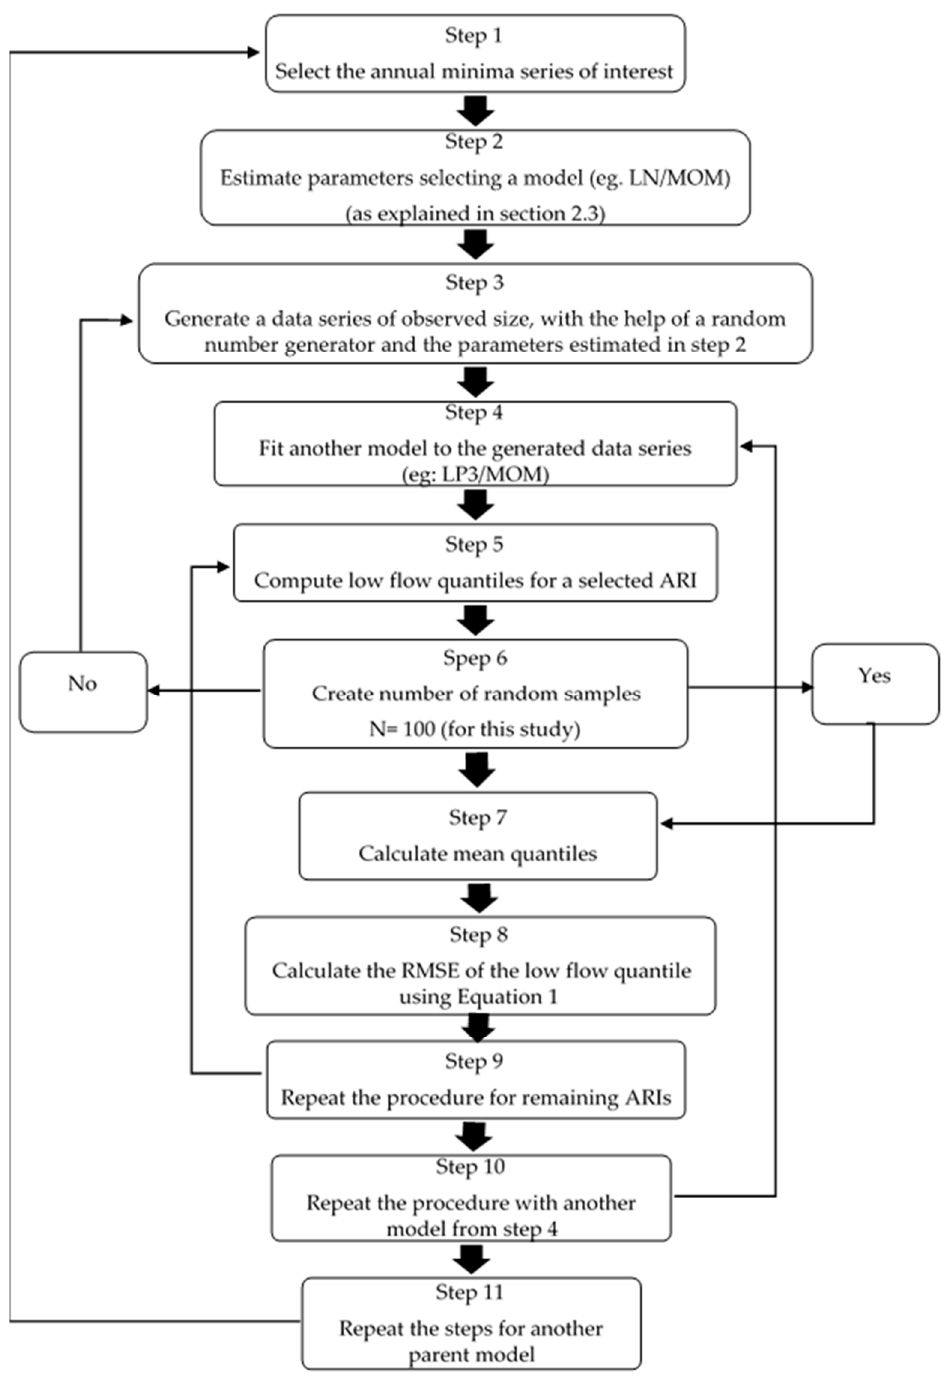
Figure 2. Simulation process.